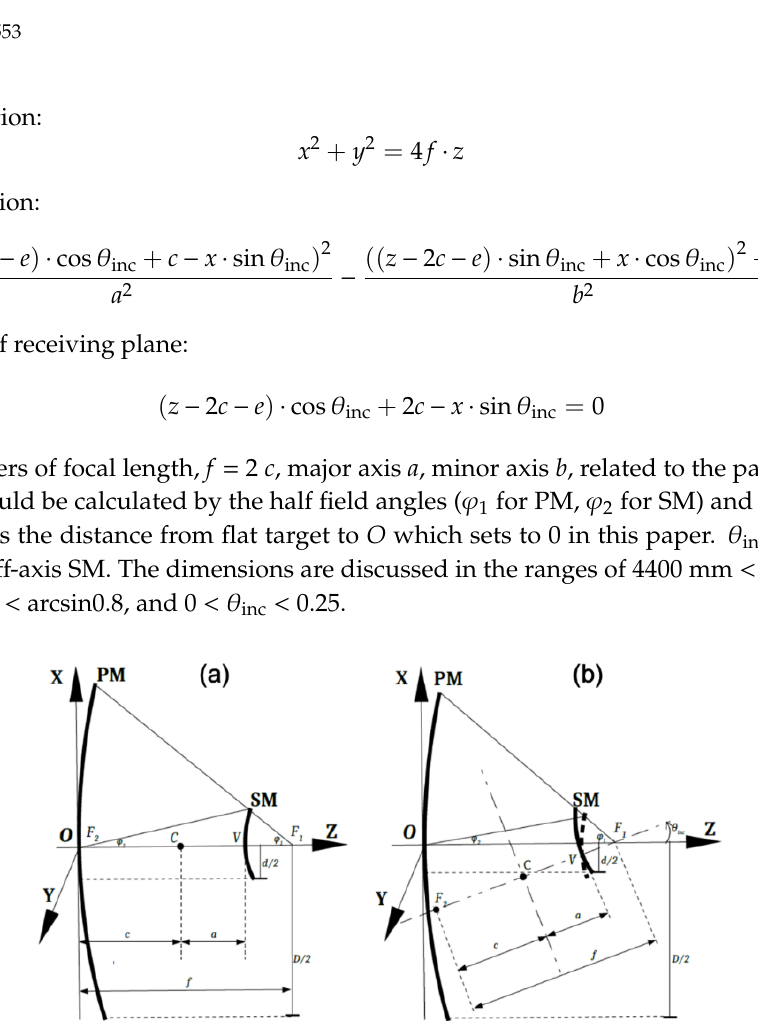
Figure 1. Sketches of two stage dish (TSD) concentrators in on/off axis conditions: Paraboloidal dish combined with ( a ) an on-axis hyperboloidal mirror, ( b ) an off-axis hyperboloidal mirror. (Not to scale).